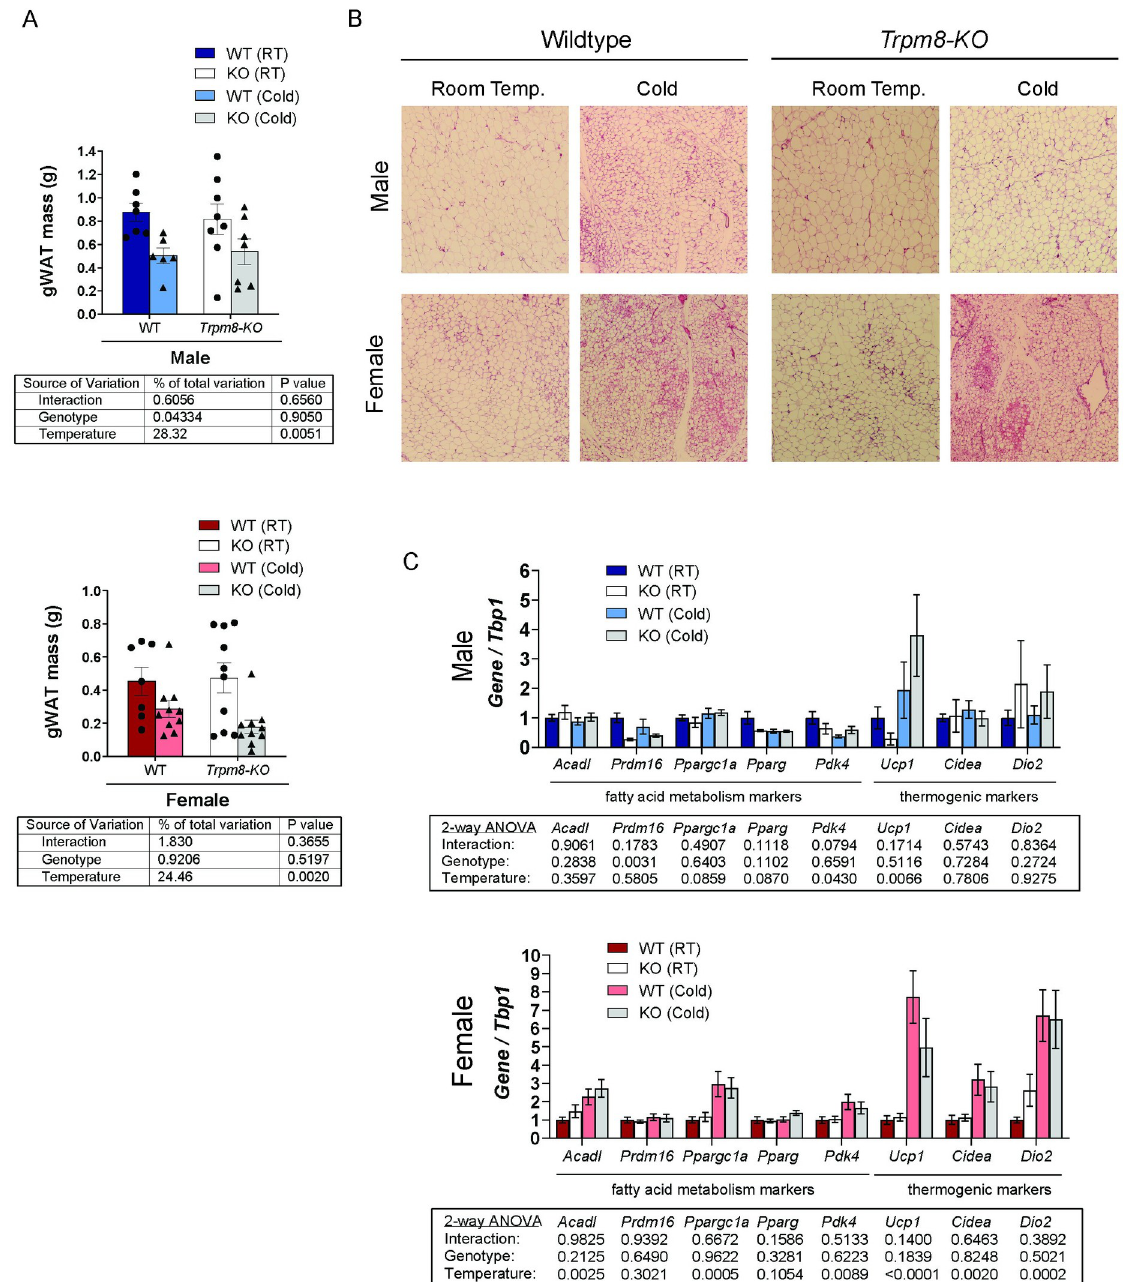
Fig 6. Loss of Trpm8 prevented beige adipocyte formation in gonadal adipose tissue from male but not female mice. (A) gWAT weights from male and female WT and Trpm8-KO housed at 22˚C and 4˚C. N = 6–10. (B) Representative H&E stained image of gWAT. N = 3–7. (C) Gene expression of fatty acid metabolism and thermogenic markers in male (top) and female (bottom) gWAT. N = 4–7. Data presented as mean ± standard error.